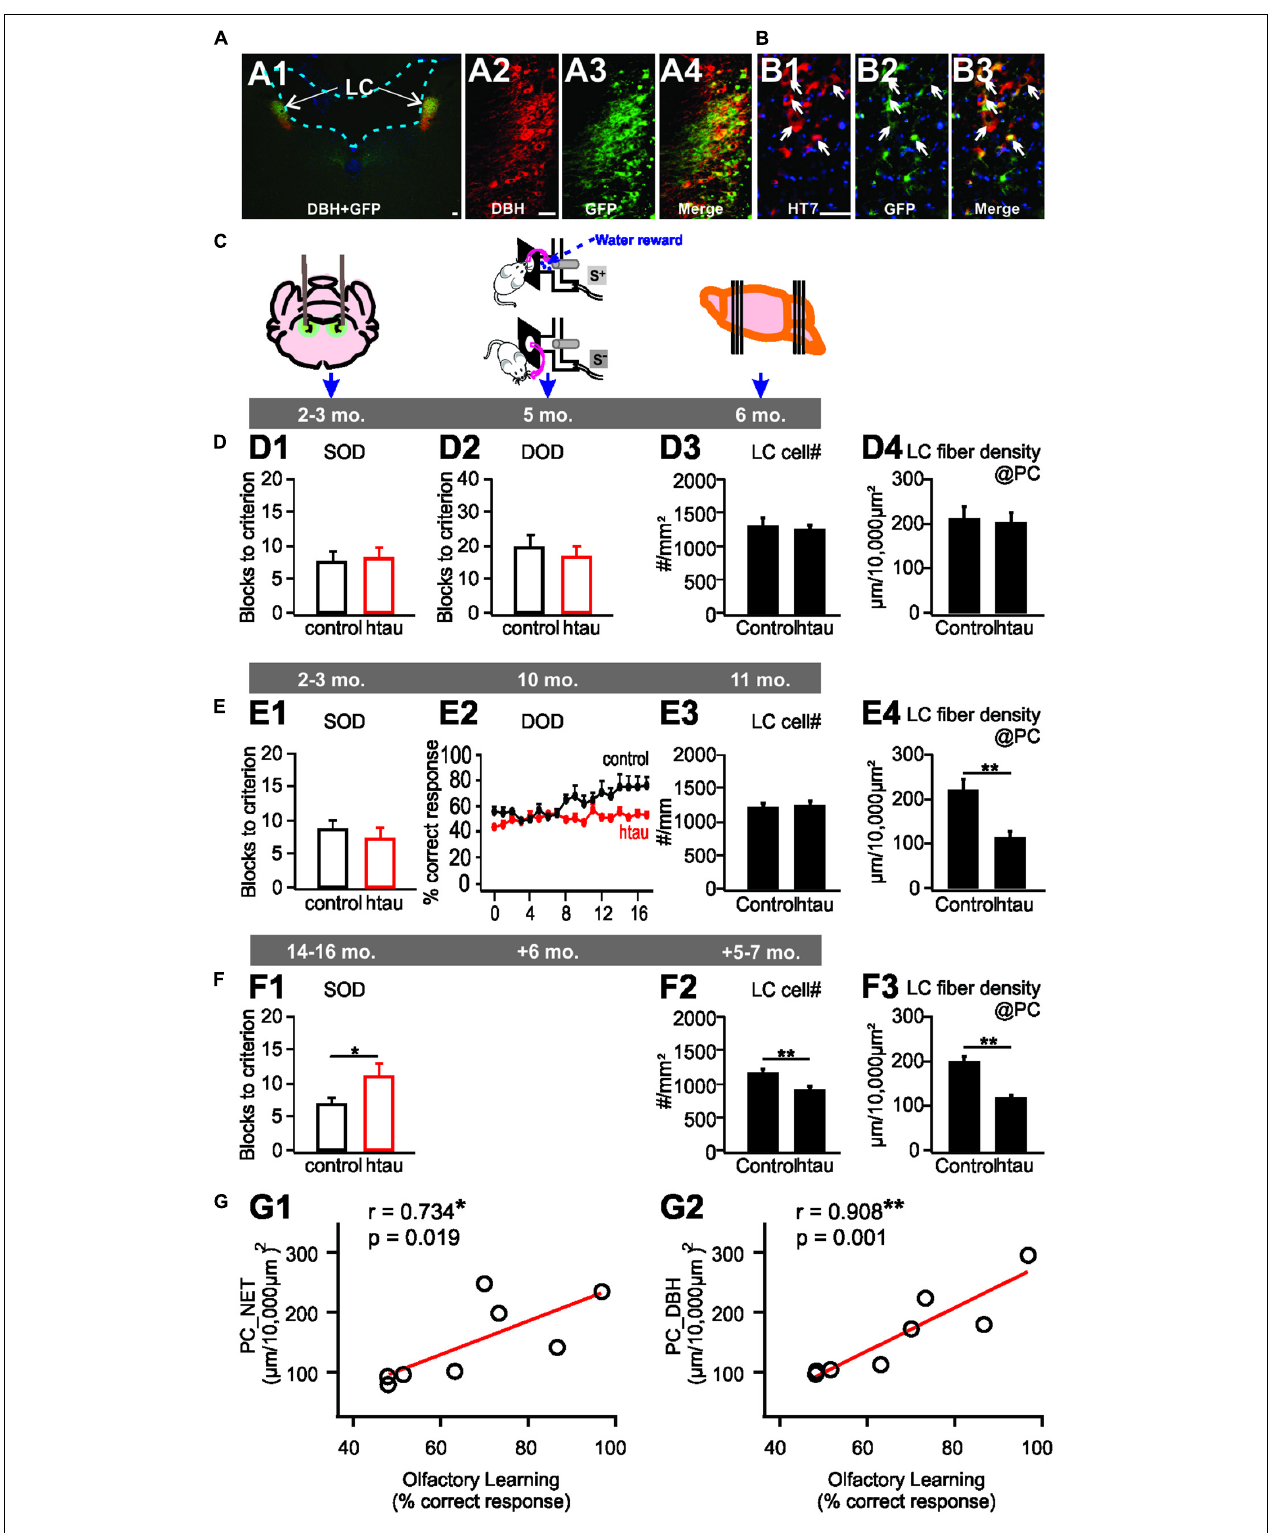
FIGURE 2 | A locus coeruleus pretangle (LC) tau model in rats. (A1–A4) htauE14-GFP uptake in the LC co-localizes with DBH + LC neurons. (B1–B3) GFP co-localizes with HT7 indexing human tau. (C) Schematics of the timeline of AAV infusion, odor discrimination training, and histology. (D1–D4) No